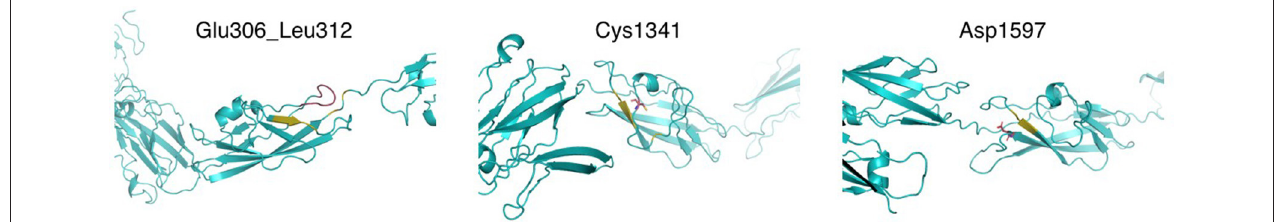
FIGURE 8 | Structural modeling of FREM1 mutations. Models of the different mutation-containing regions in FREM1 were produced by trRosetta. Left: region showing Glu306_Leu312 in CSPG1 and nearby residues (estimated TM-score = 0.546). The segment Glu306_Leu312 is colored red and the predicted contacts are shown in olive. Center: region containing CSPG9, highlighting Cys1341 in red sticks and predicted contacts in olive (estimated TM-score = 0.547). Right: region containing CSPG11, highlighting Asp1597 in red sticks and predicted contacts in olive (estimated TM-score =